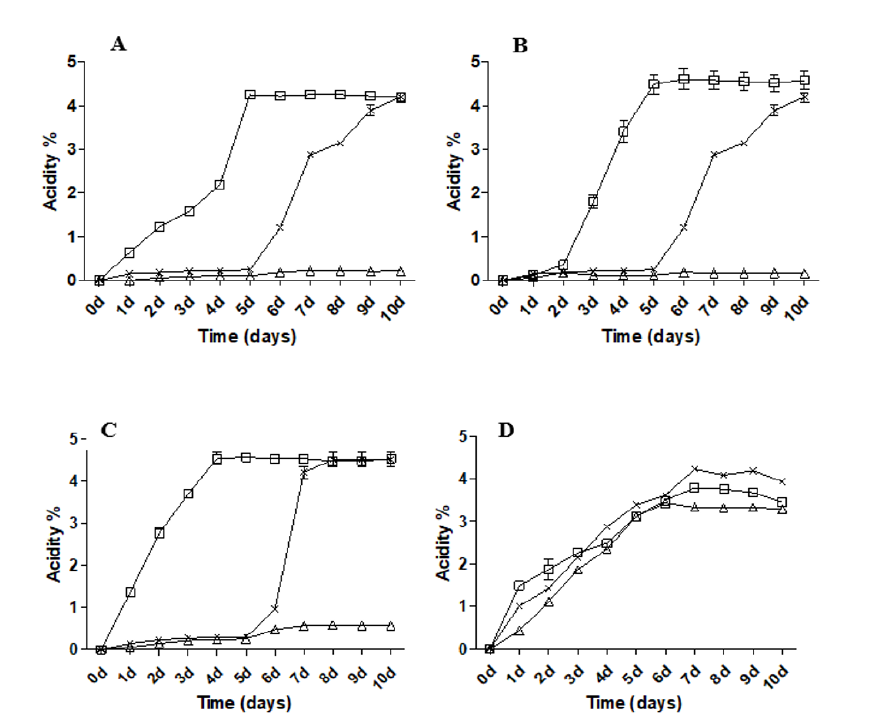
Figure 2: Comparison of acetic acid production of A. pasteurianus AB5 (A) PP21; (B) A. pomorum SC31; (C) with A. Pasteurianus SL13E-2 and (D) the reference strain at 30 ℃ (Squares), 36 ℃ (Crosses), and 37 ℃ (Triangles) with 6% initial ethanol